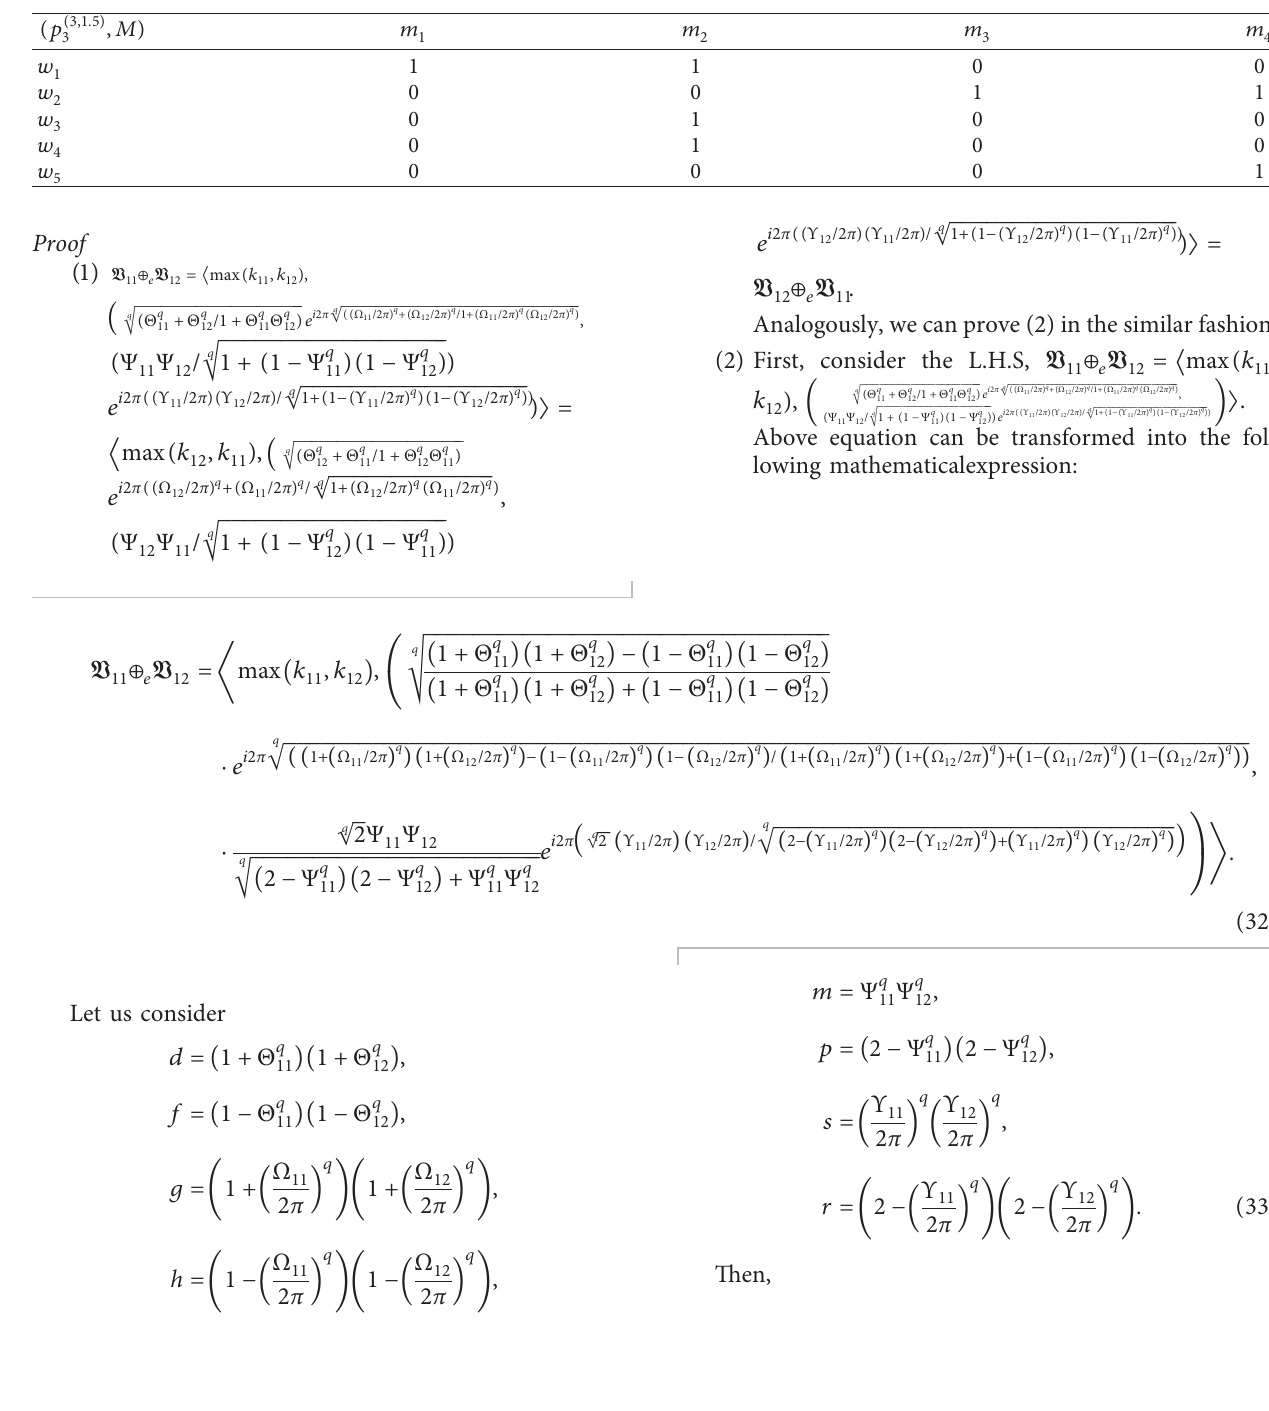
Table 17: Identified